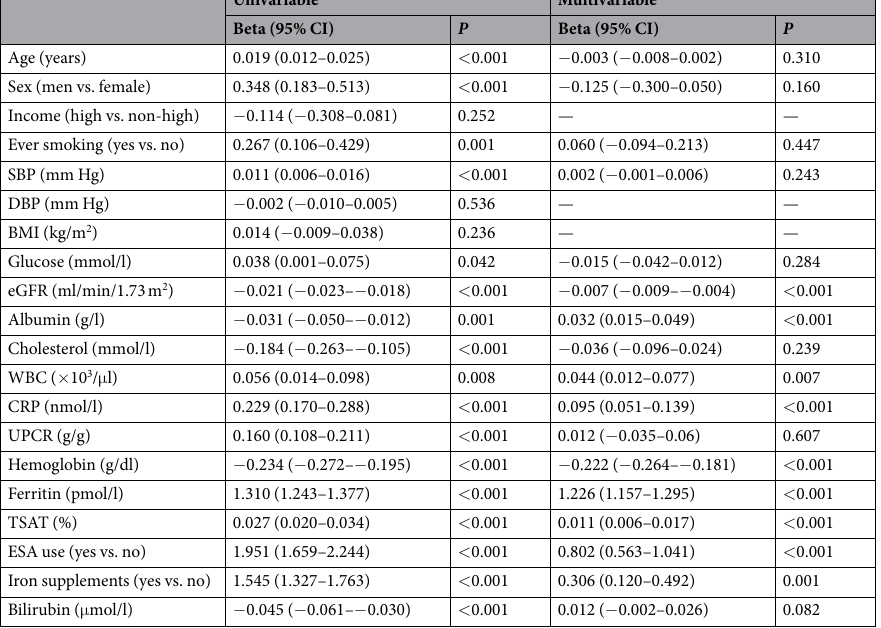
Table 3. Linear regression analysis for the square root of serum hepcidin level. SBP, systolic blood pressure; DBP, diastolic blood pressure; BMI, body mass index; eGFR, estimated glomerular filtration rate; WBC, white blood cells; CRP, C-reactive protein; UPCR, urine protein-to-creatinine ratio; TSAT, transferrin saturation; ESA, erythropoiesis stimulating agents. Logarithmic transformations were done for CRP, UPCR and ferritin. In multivariable linear regression analysis, variables with P < 0.05 in univariable linear regression analysis were chosen as